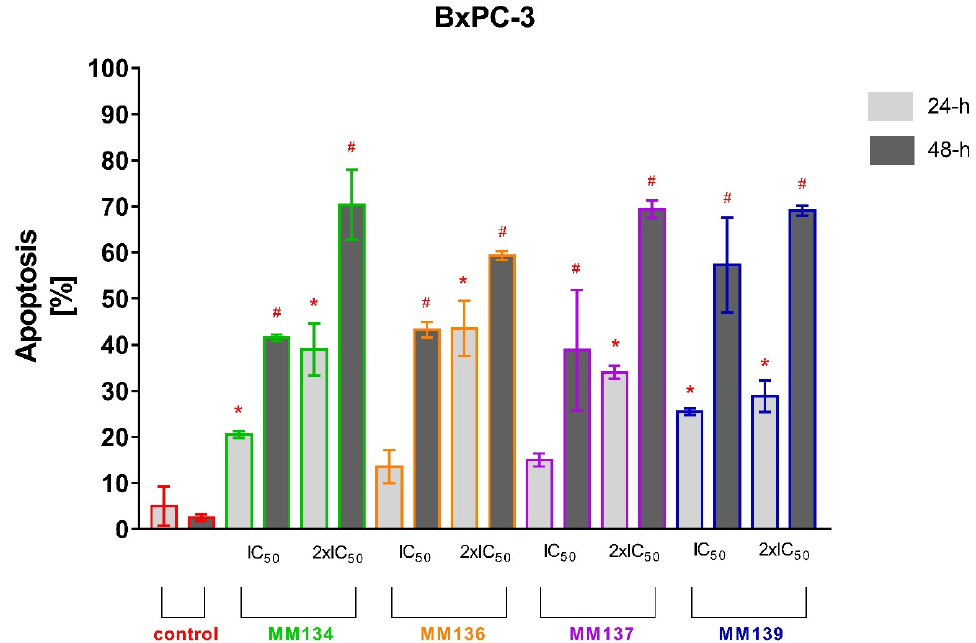
Figure 8. Determination of apoptosis induction in PC-3 cell line treated with IC 50 and 2xIC 50 concen- trations of MM-compounds measured with AO/EB double staining following 24 and 48 h incubation time. Data are presented as mean percentage of apoptotic cells (early and late apoptotic) ± SD values. The differences between the experimental samples and vehicle control were evaluated by the ANOVA test followed by Tukey’s test ( p < 0.05). * significant difference compared to the negative control (24 h incubation time); # significant difference compared to the negative control (48 h incubation time); p < 0.05; N =